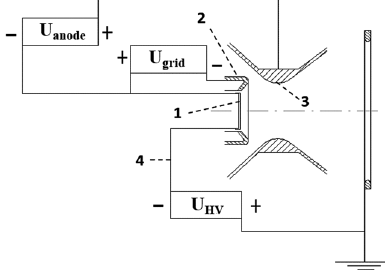
FIG. 2. Schematic view of the EC35 gun. 1-cathode, 2-grid, 3-anode, 4-HV.